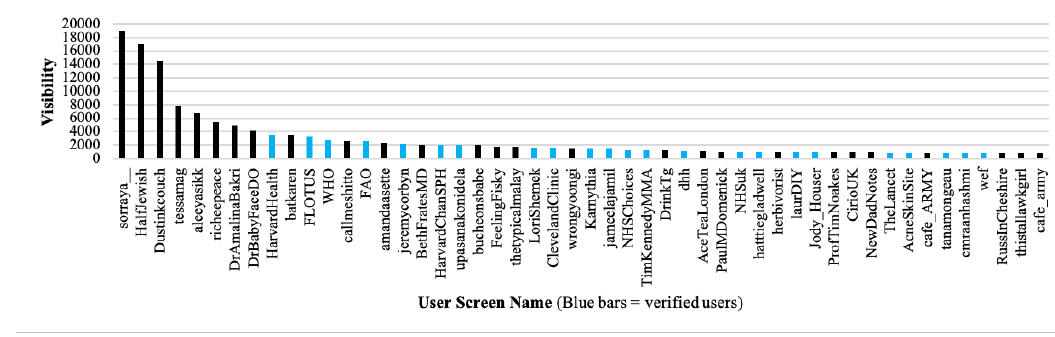
Figure 3. Most Visible Users.